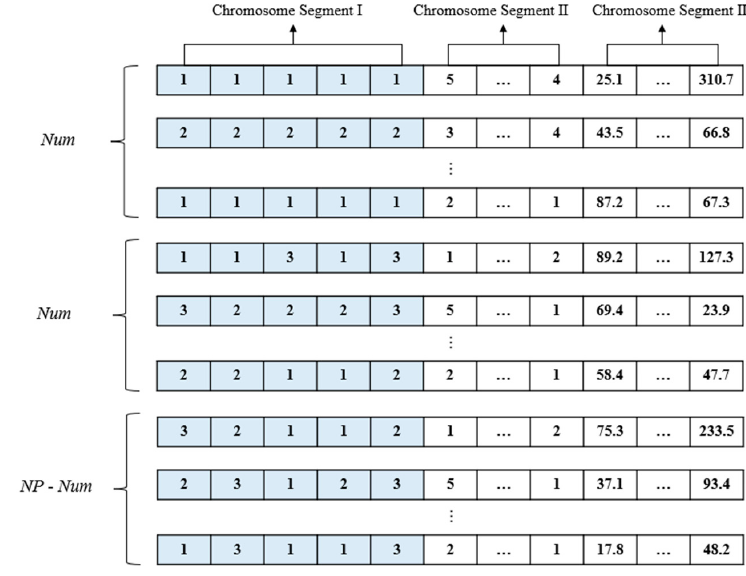
Figure 5. The proposed population initialization method.